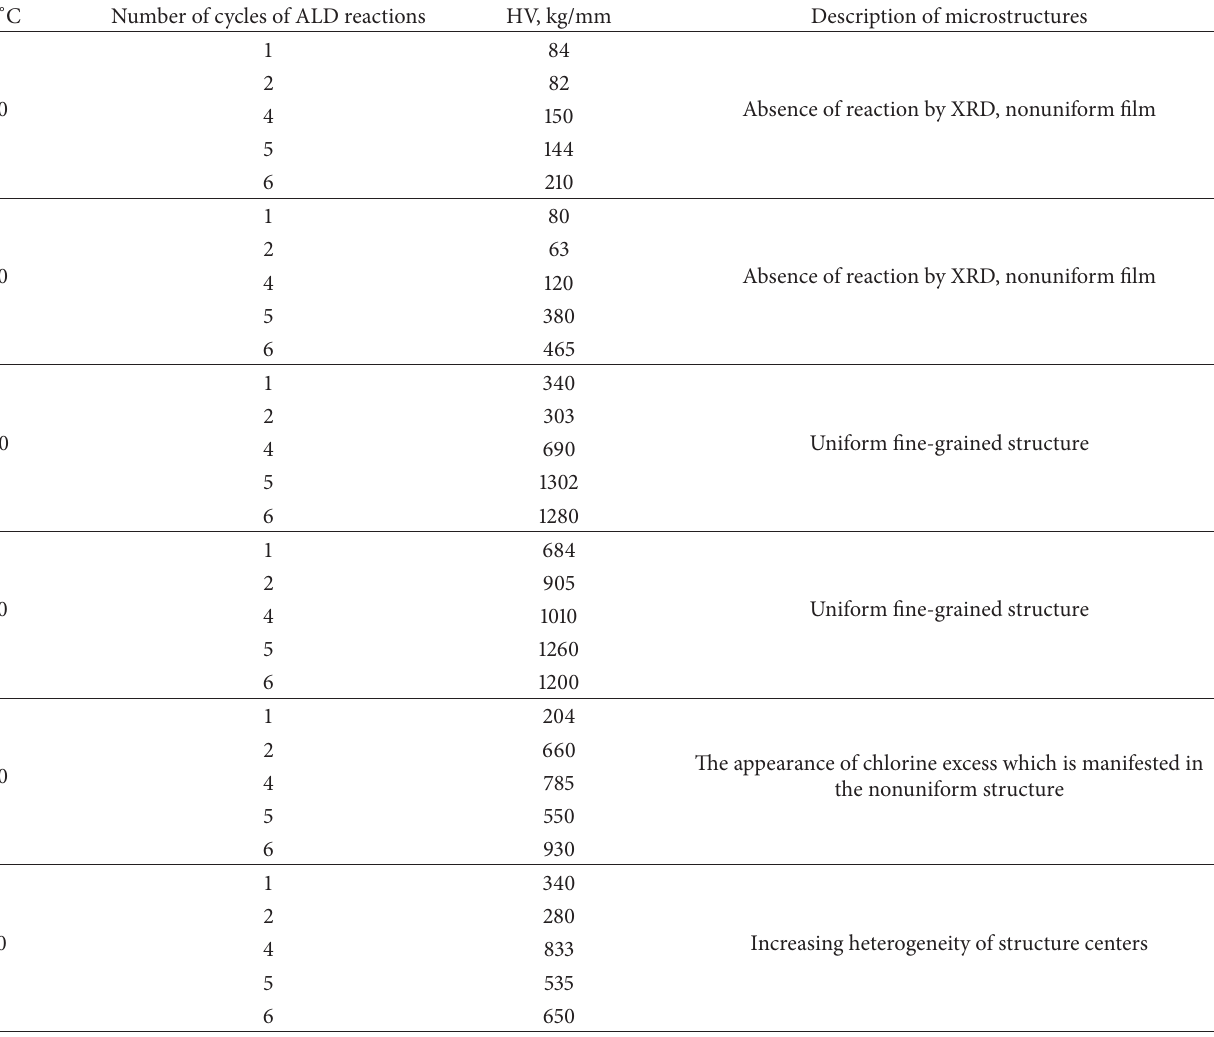
Table 2: Macrohardness and characterization of the microstructure of samples obtained by alternating exposures of titanium tetrachloride- methane.